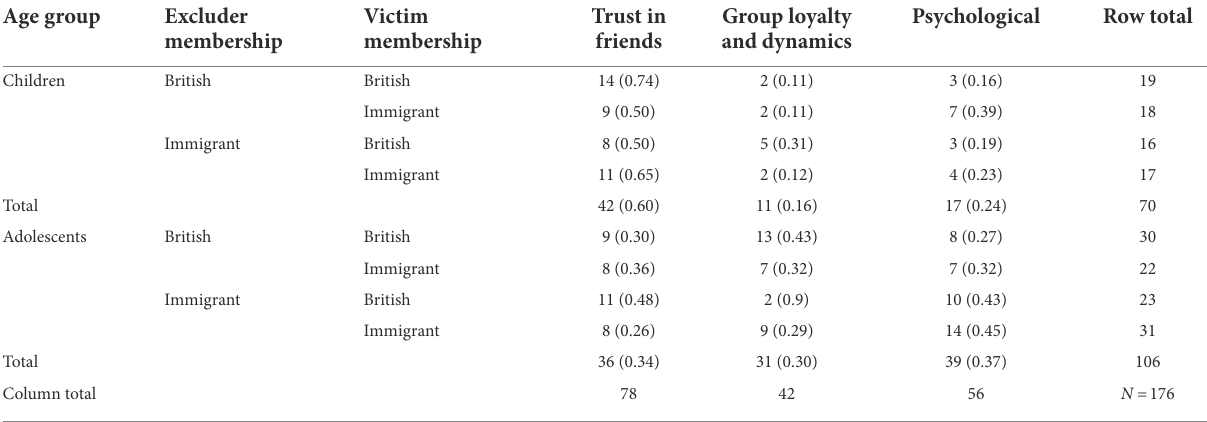
TABLE 6 Frequencies and proportions of participants’ reasoning of getting help from a friend as a function of age group, the group membership of excluder, and the group membership of the victim. Age